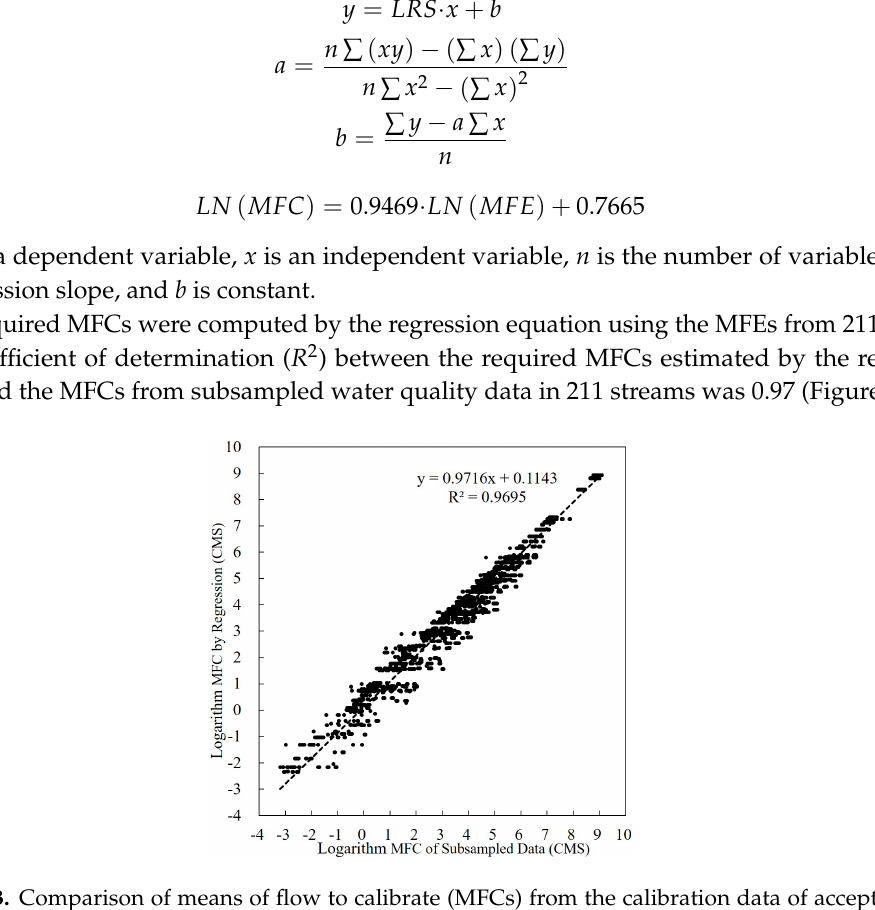
Figure 3. Comparison of means of flow to calibrate (MFCs) from the calibration data of acceptable annual sediment loads and the required MFCs by Equation (8). annual sediment loads and the required MFCs by Equation